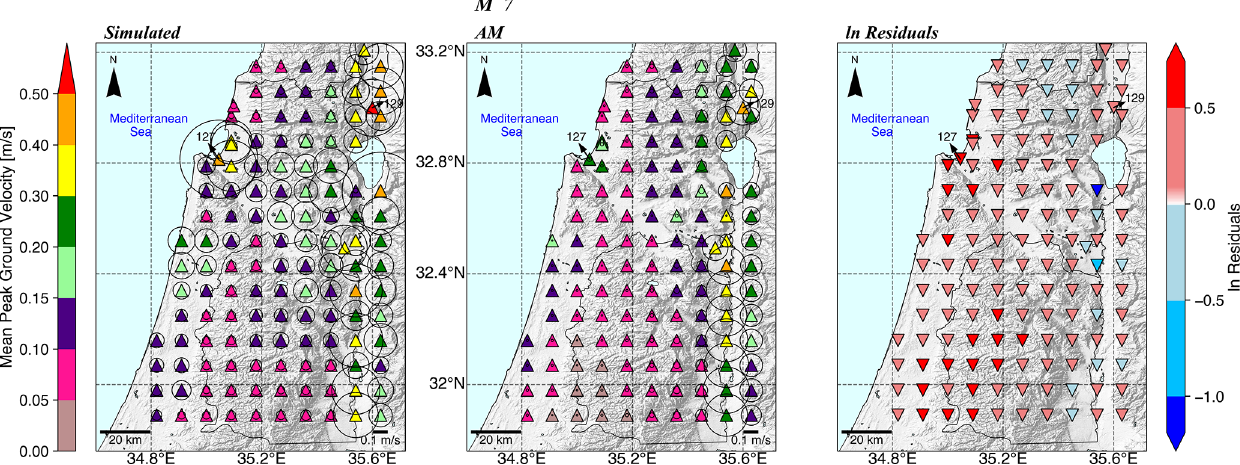
Figure 8. Map view of simulated and AM mean PGVs (triangles) for M 7 and their standard deviation (diameters of the circles) at each station, with the respective residuals in ln units (inverted